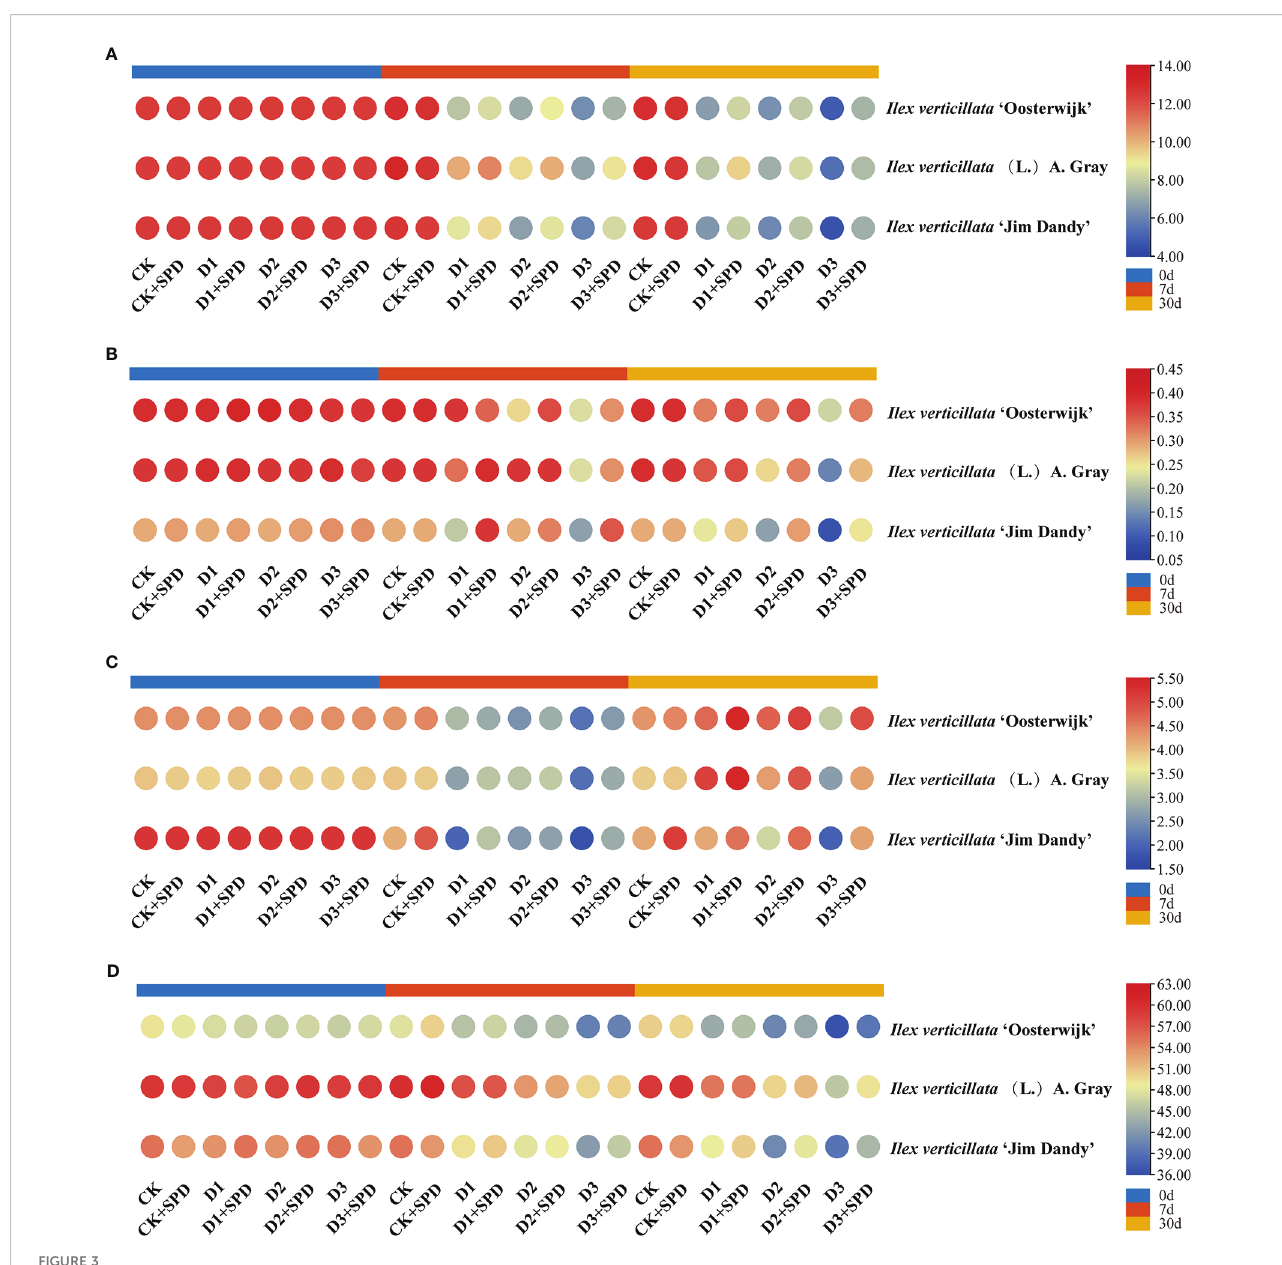
FIGURE 3 The changes of photosynthetic parameters in Ilex verticillata leaves under drought and spermidine treatment. (A) photosynthetic rate; (B) stomatal conductance; (C) transpiration rate; (D) chlorophyll content. Data were shown in different heatmaps, where red indicates high values and blue indicates low values. CK, control; CK+SPD, control with spermidine; D1, mild drought; D1+SPD, mild drought with spermidine; D2, moderate drought; D2+SPD, moderate drought with spermidine; D3, severe drought; D3+SPD, severe drought with